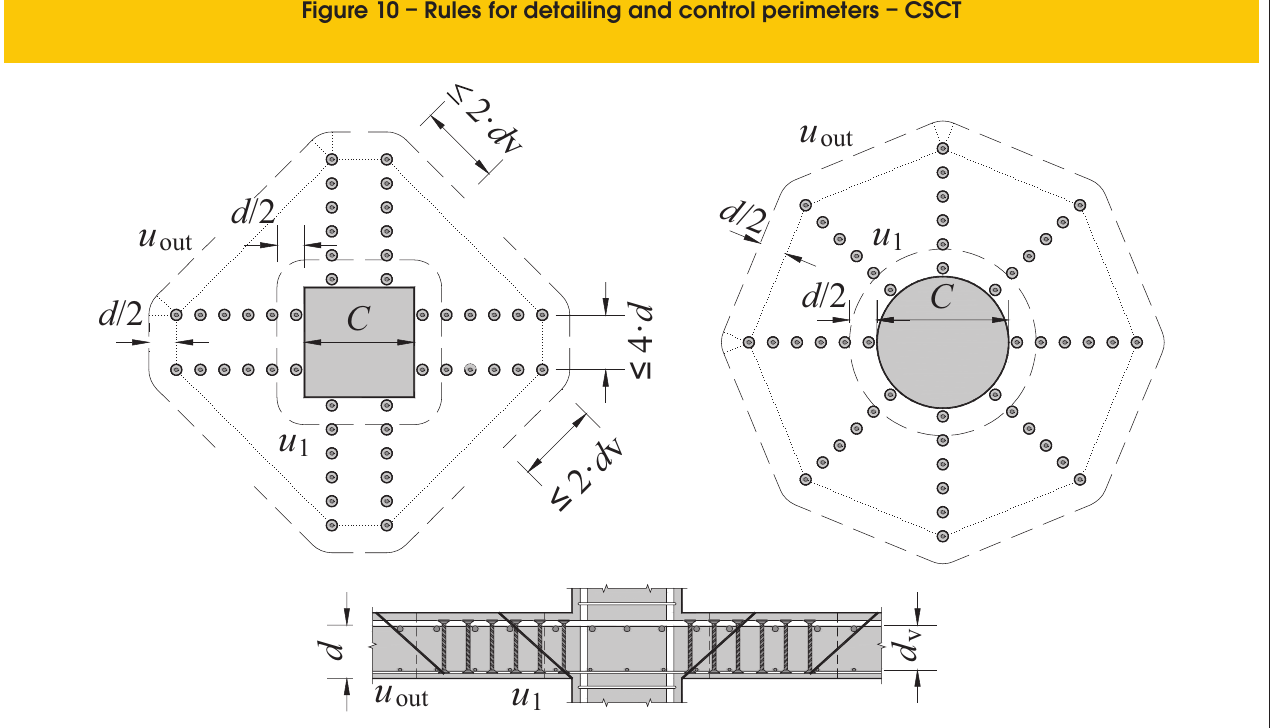
Figure 10 – Rules for detailing and control perimeters –